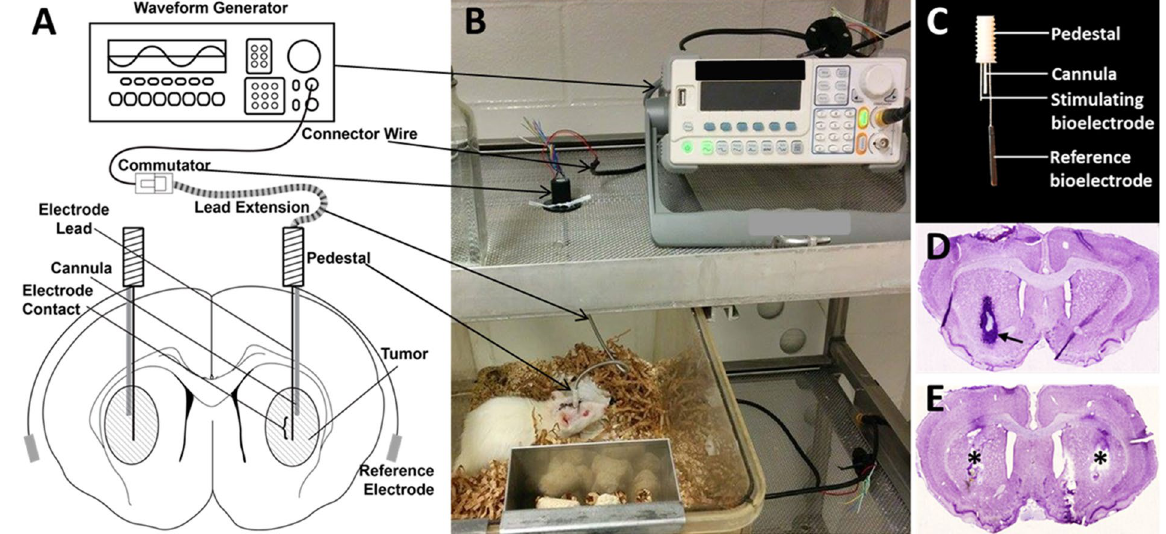
Figure 3. In vivo model to evaluate IMT in GBM. ( A ) Schematic and ( B ) photographic depiction of the in vivo IMT model. The animals could roam freely throughout the home cage. Bilateral GBM tumors were randomized so that one would receive sham treatment (i.e., hardware but no stimulation) and the other IMT between postoperative days 4–11. This provided an internal control tumor for every subject. ( C ) The IMT construct consisted of a lead with a single 1-mm stimulating bioelectrode, a cannula to deliver the GBM cells and a reference bioelectrode. The stimulating bioelectrode was located at the core of the GBM tumors and the reference bioelectrode positioned extracranially under the scalp. ( D ) Representative thionine-stained section of a control brain demonstrating a 4-day GBM, reflecting the tumor size when IMT was initiated (arrow). ( E ) Representative thionine-stained section through another control brain to show the effects of IMT on normal parenchyma. There was no tumor in this subject however bilateral IMT constructs were placed for delivery of 1 week of sham (left) or IMT (right). Symmetric hardware defects were evident (asterisks) without overt parenchymal injury from the